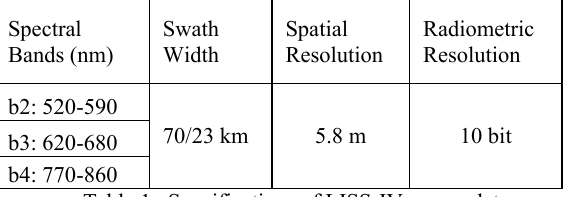
Figure 1. Location map of Koraput district